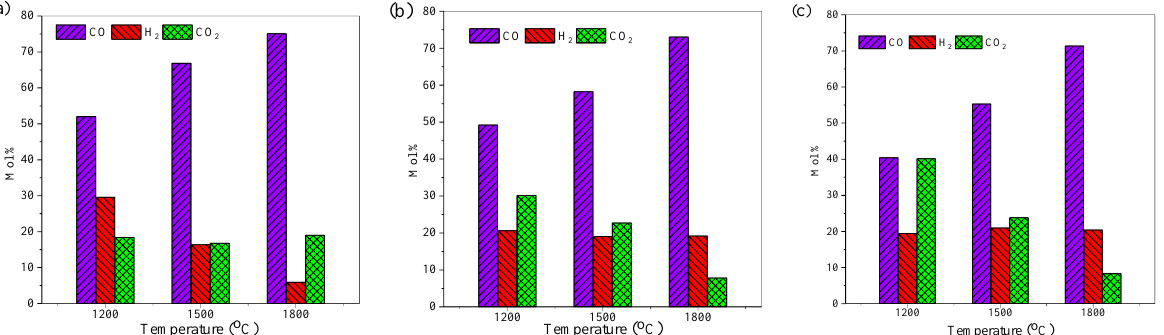
Figure 6. Influence of the wall temperature on the coal gas composition ( a ) at O/C = 0.9, ( b ) at O/C = 1, and ( c ) at O/C = 1.1.